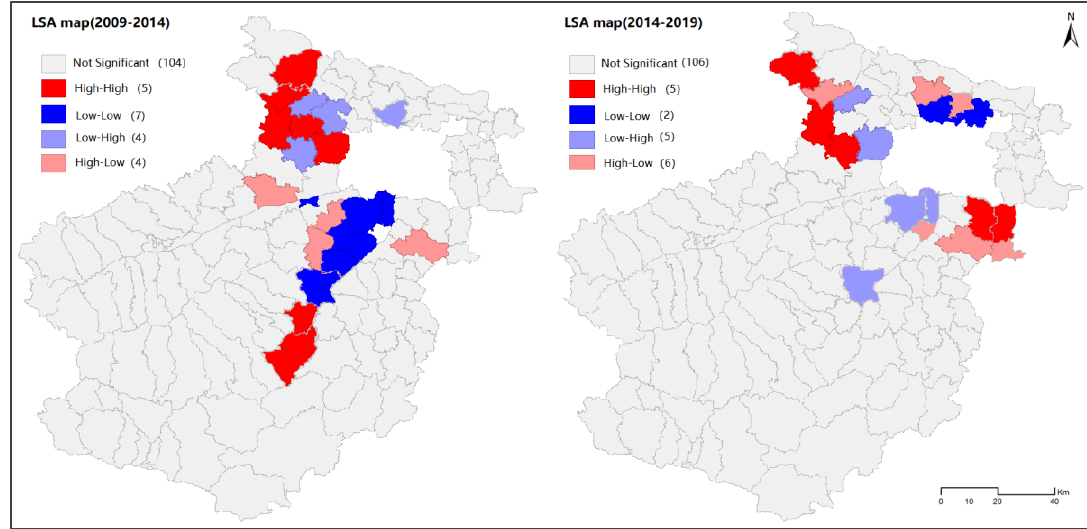
Figure 12. 2 period elasticity coefficient local spatial correlation aggregation map.